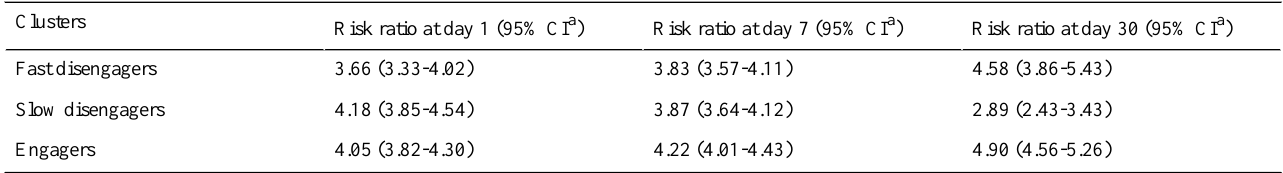
Table 4. Estimated risk ratio with 95% CI for the associations between exposure to the notification and app use within each cluster, at 3 time points (days 1, 7, and